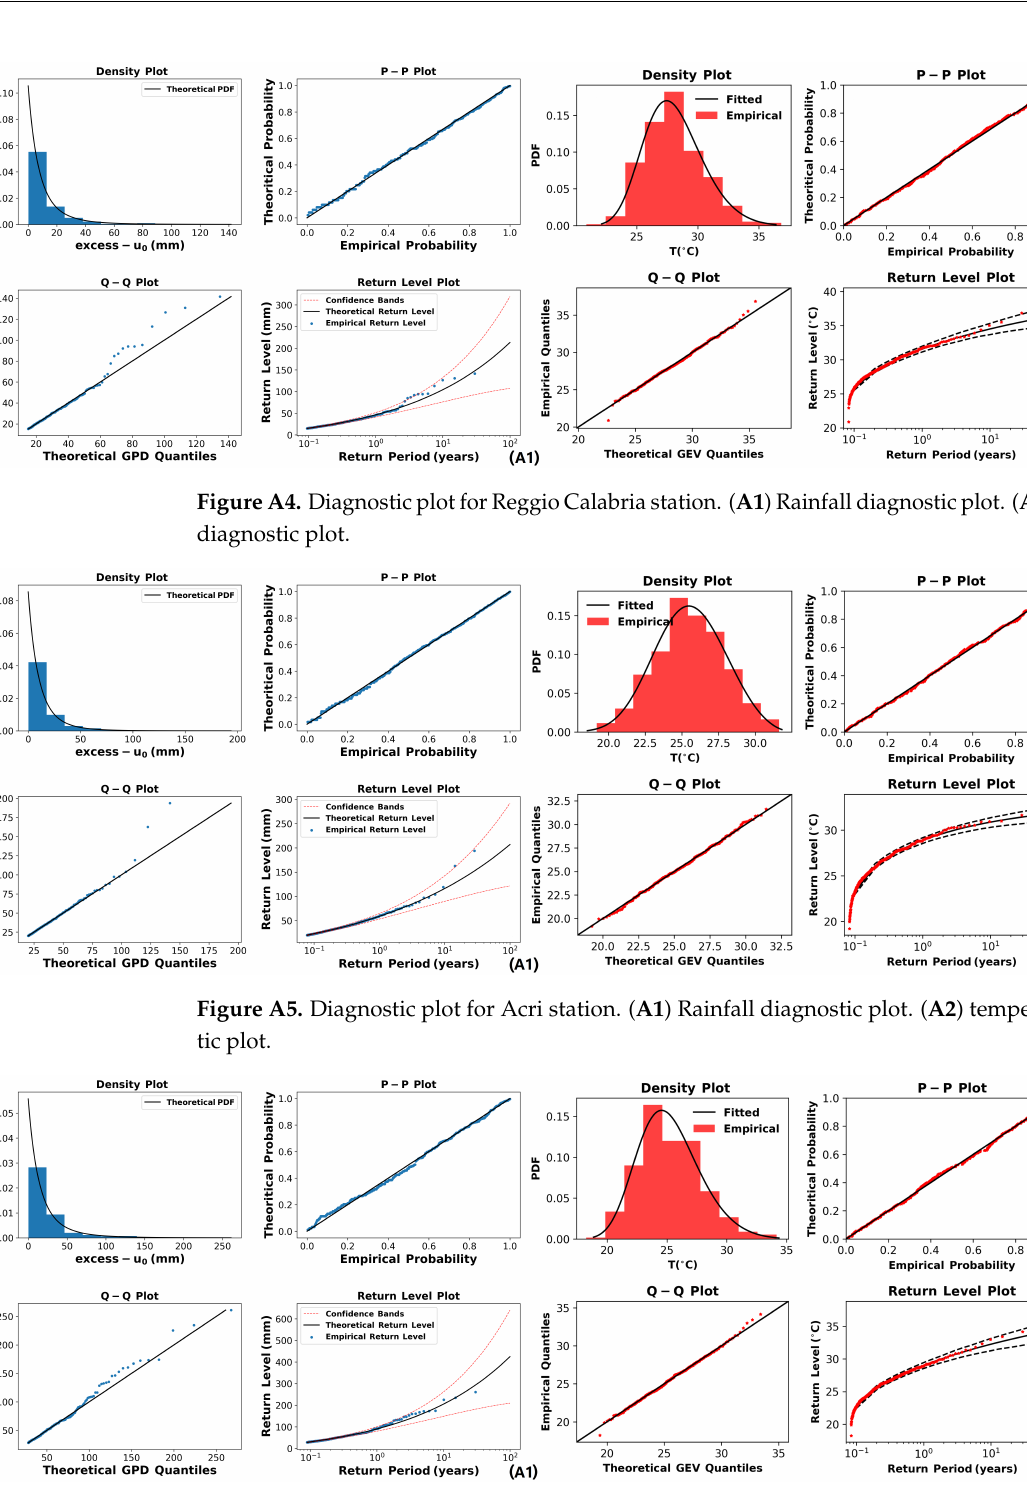
Figure A6. Diagnostic plot for Palermiti station. ( A1 ) Rainfall diagnostic plot. ( A2 ) temperature diagnostic